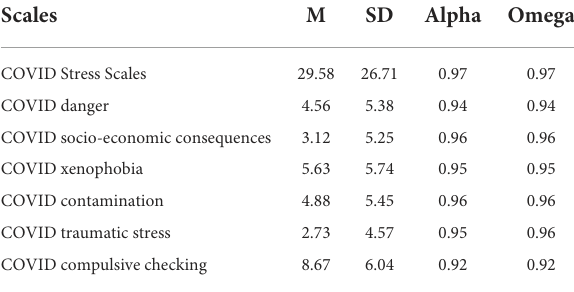
TABLE 3 Normative data and reliability indices for the COVID Stress Scales and its subscales ( n = 2,116). Scales M SD